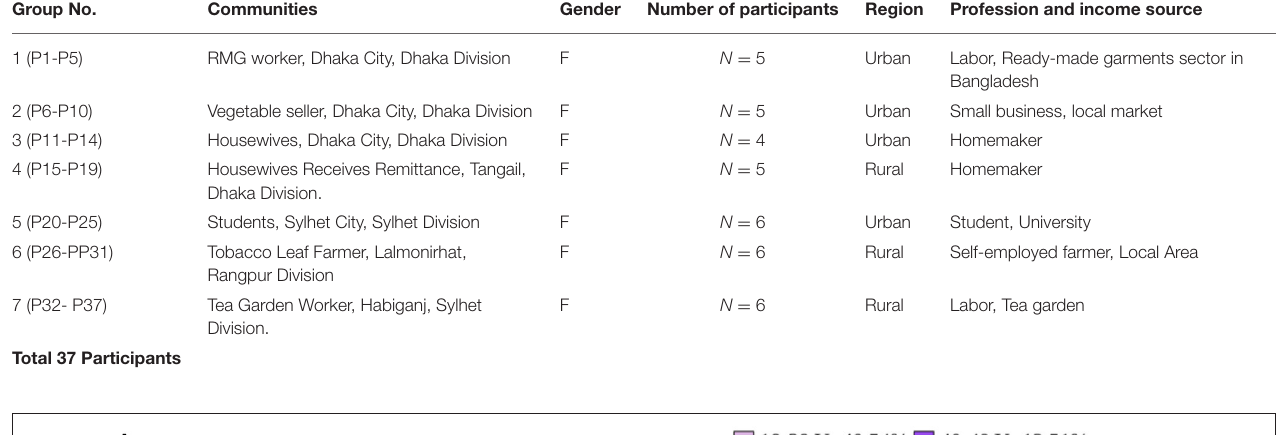
TABLE 1 | Participant details. Group No.